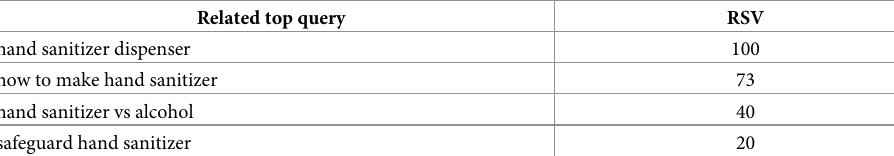
Table 3. Related top queries and search interest value for “hand sanitizer”.